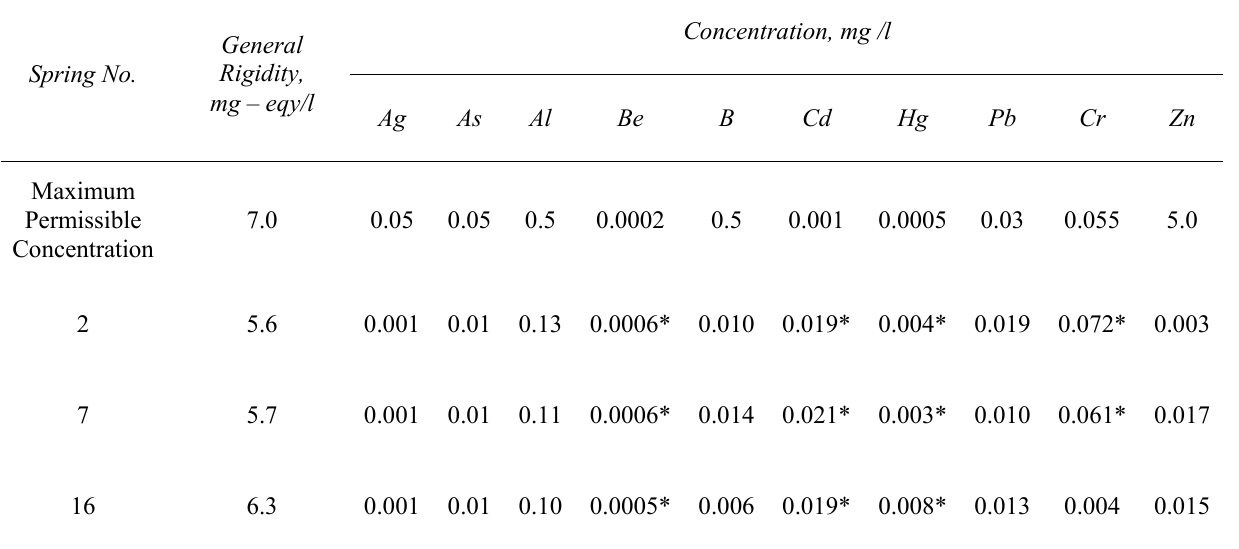
Concentration, mg /l